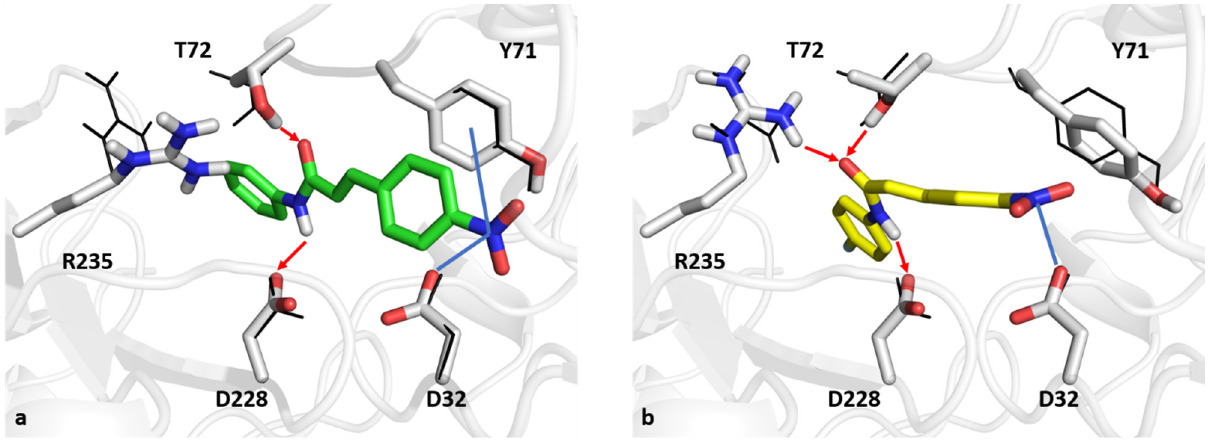
Figure 3. The best-docked poses of compounds NEA1 ( a , green sticks) and NEA3 ( b , yellow sticks) in a BACE1 binding pocket. Blue lines and red arrows indicate ion-dipole interactions and hydrogen bonds, respectively. Black wireframes report the original pose of BACE1 sidechains in the binding site.